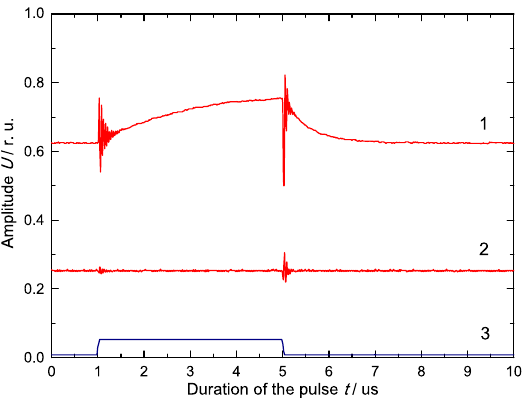
Figure 4. Circuit diagram of the input stage of the NQR spectrometer.